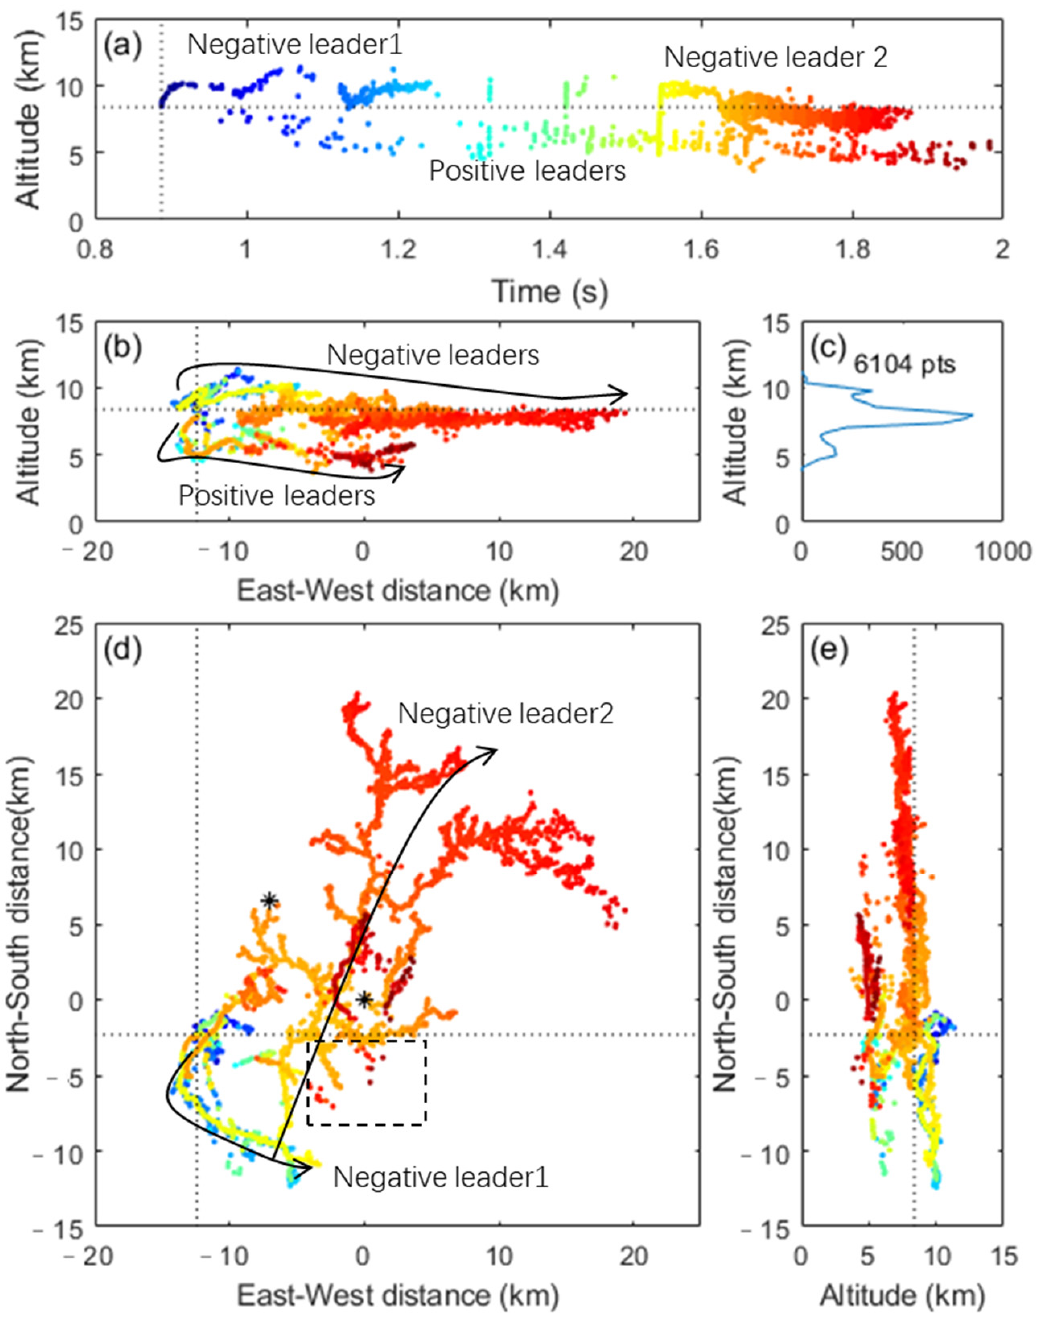
Figure 4. Three-dimensional location results of an intra-cloud lightning flash. ( a ) height with time, ( b ) north–south vertical projection, ( c ) height distribution of the number of radiation sources, ( d ) plane projection, and ( e ) east–west vertical projection of the three-dimensional location result. Asterisks are positions of the interferometer. Dashed lines intersect at the initiation point of the flash.